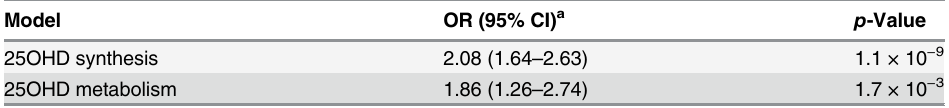
Table 4. Mendelian randomization estimate of the association of decreased 25OHD with the risk of multiple sclerosis stratified by SNPs near genes involved in 25OHD synthesis versus metabolism using a fixed-effects model.